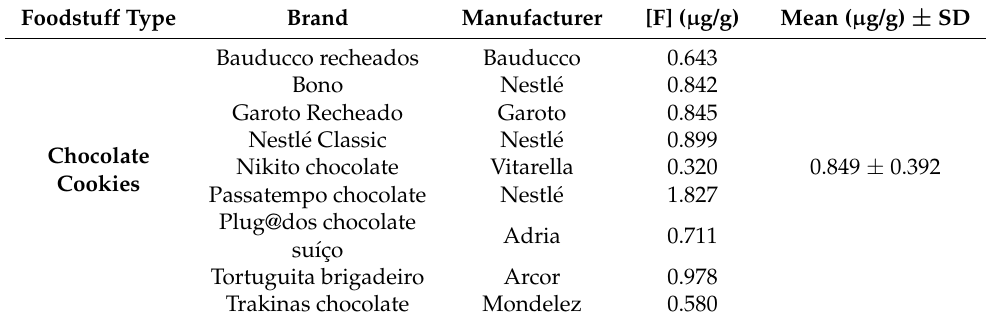
Table 5. Mean of fluoride content of the different types of chocolate cookies that were